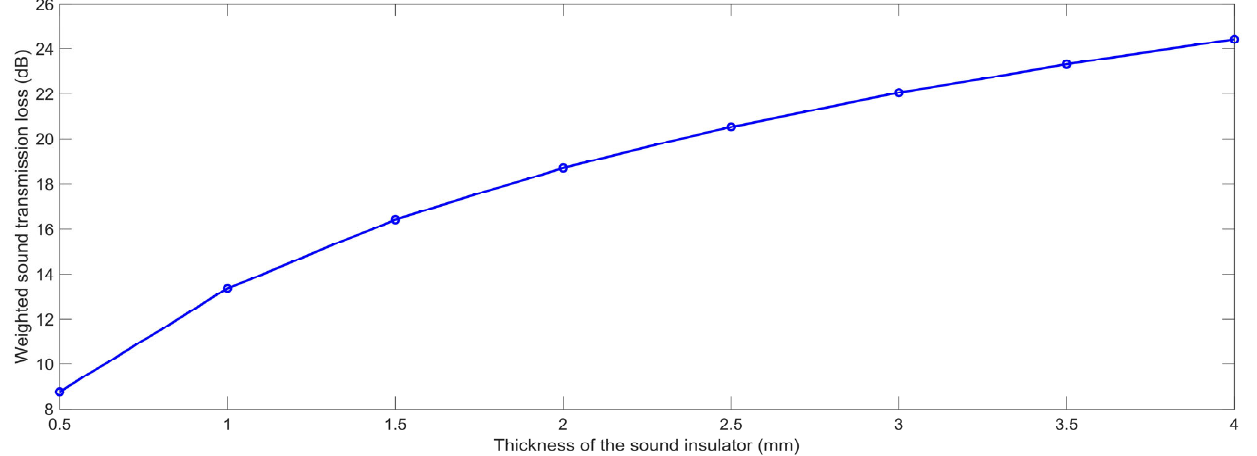
Figure 13. The weighted STL of the composite rubber reinforced with HGM for various thickness of the sound insulator.